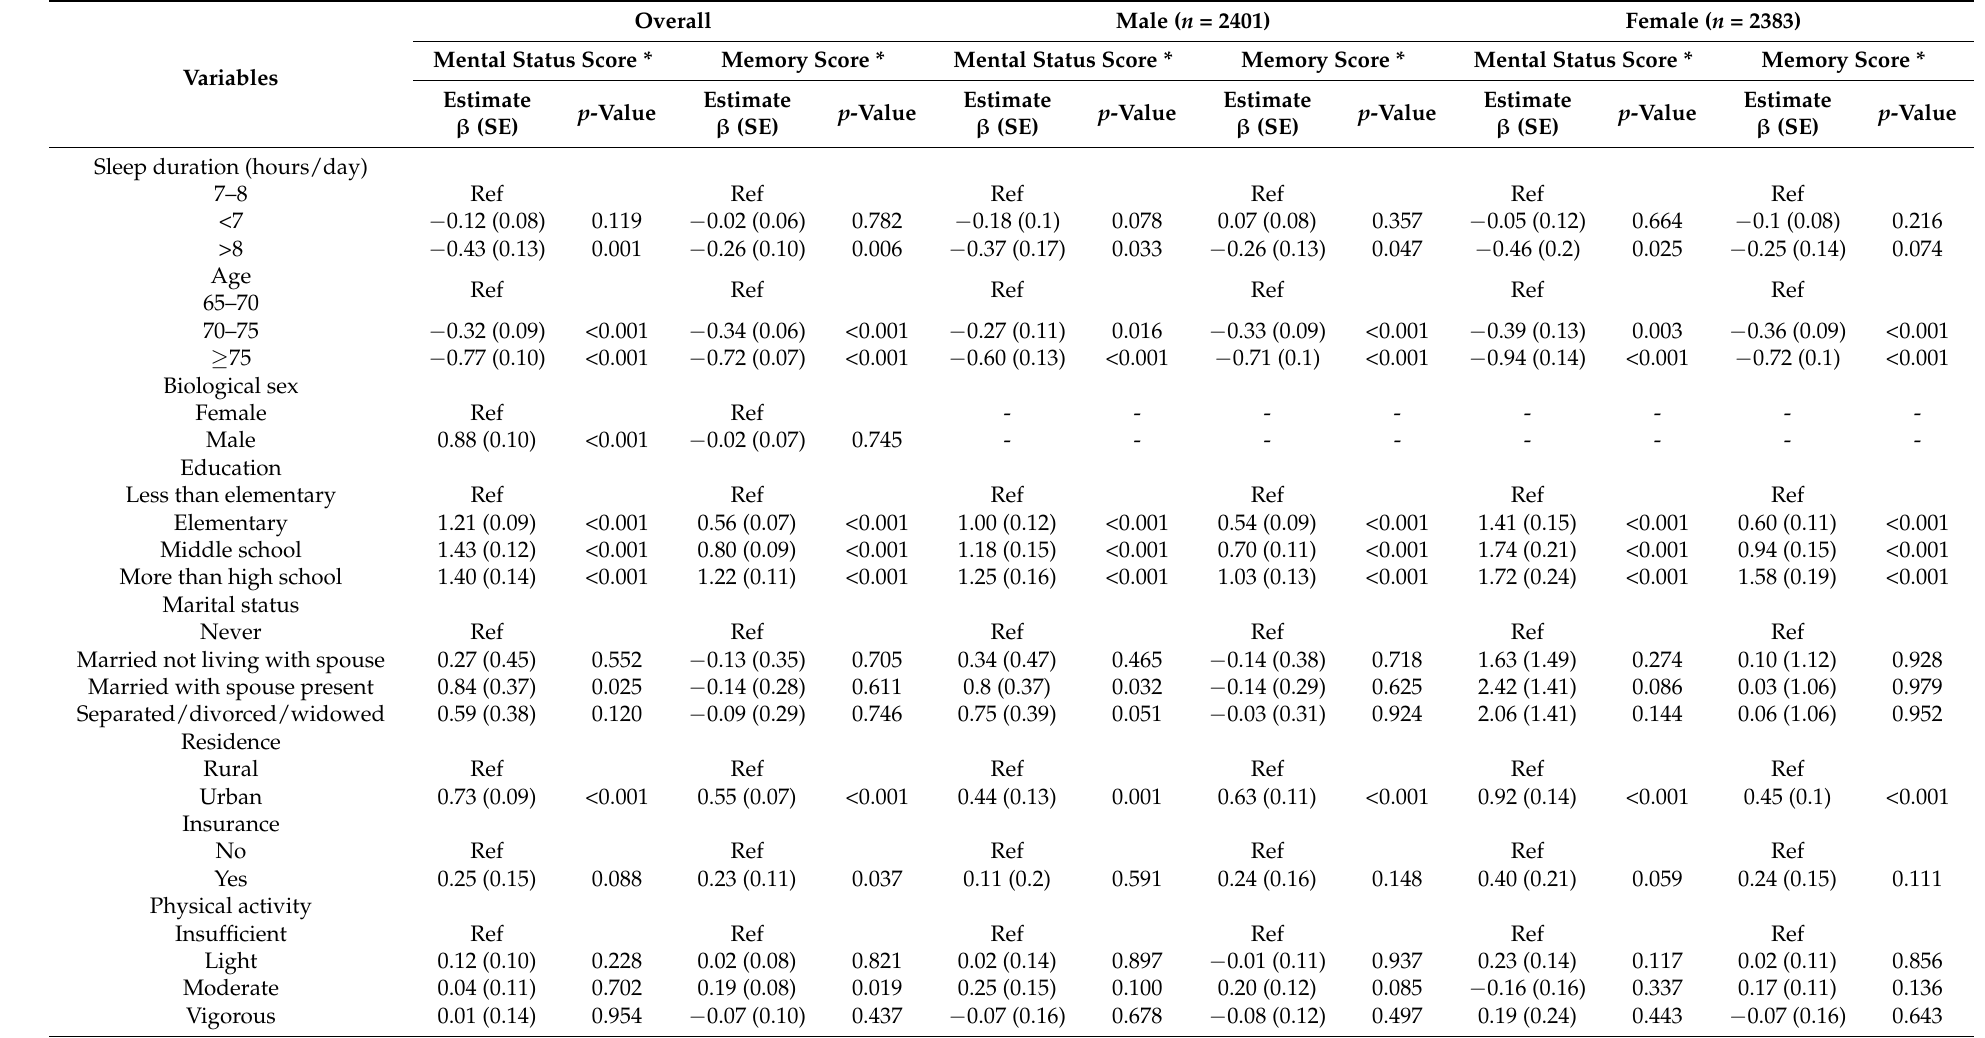
Table 2. Generalized linear modeling assessing the association between sleep duration and cognitive function ( n =